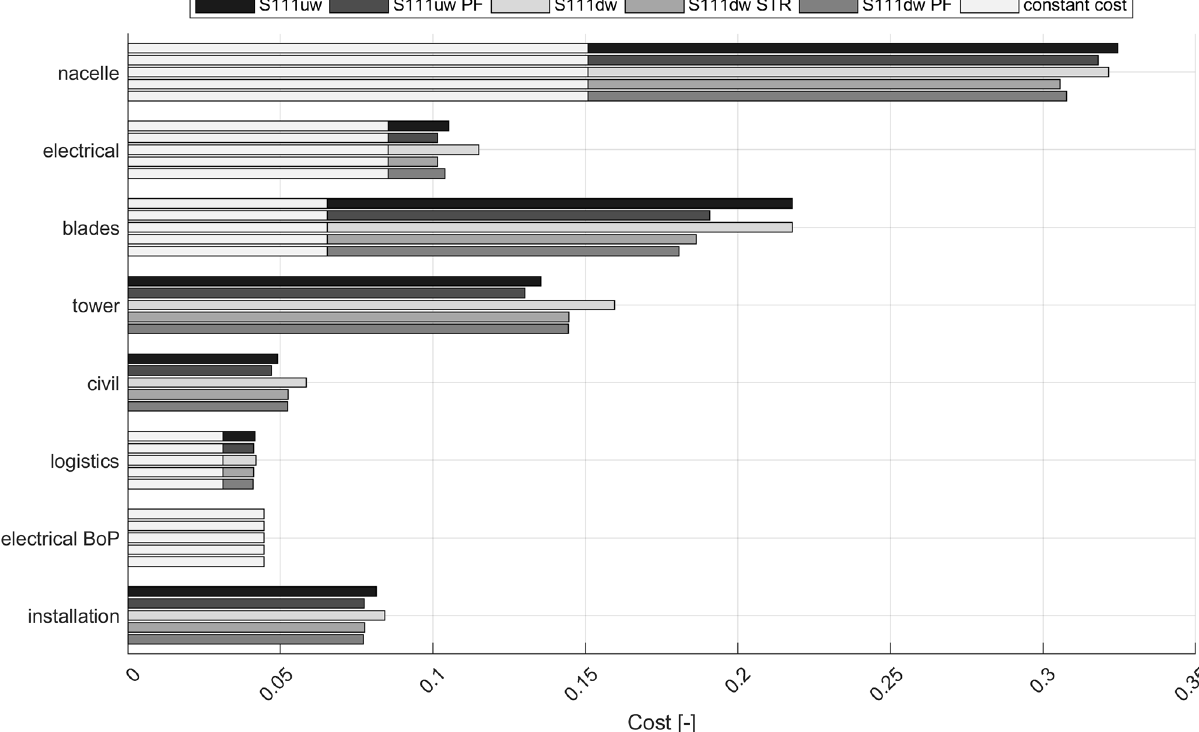
Figure 6. Turbine CAPEX cost split by main cost components normalized by the sum of the S111uw configuration with an indication of constant costs not affected by the redesign